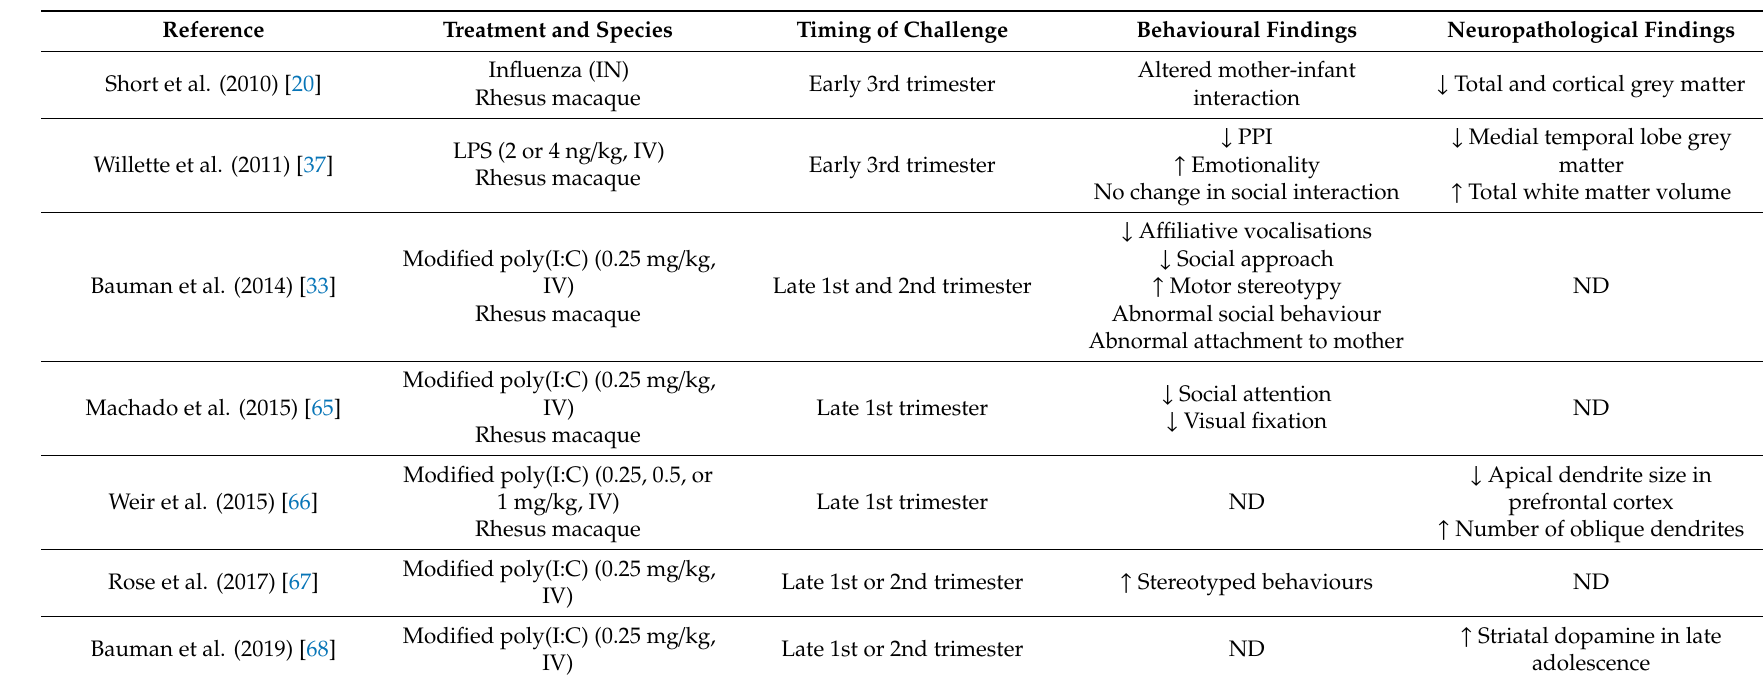
Table 2. Primate models of